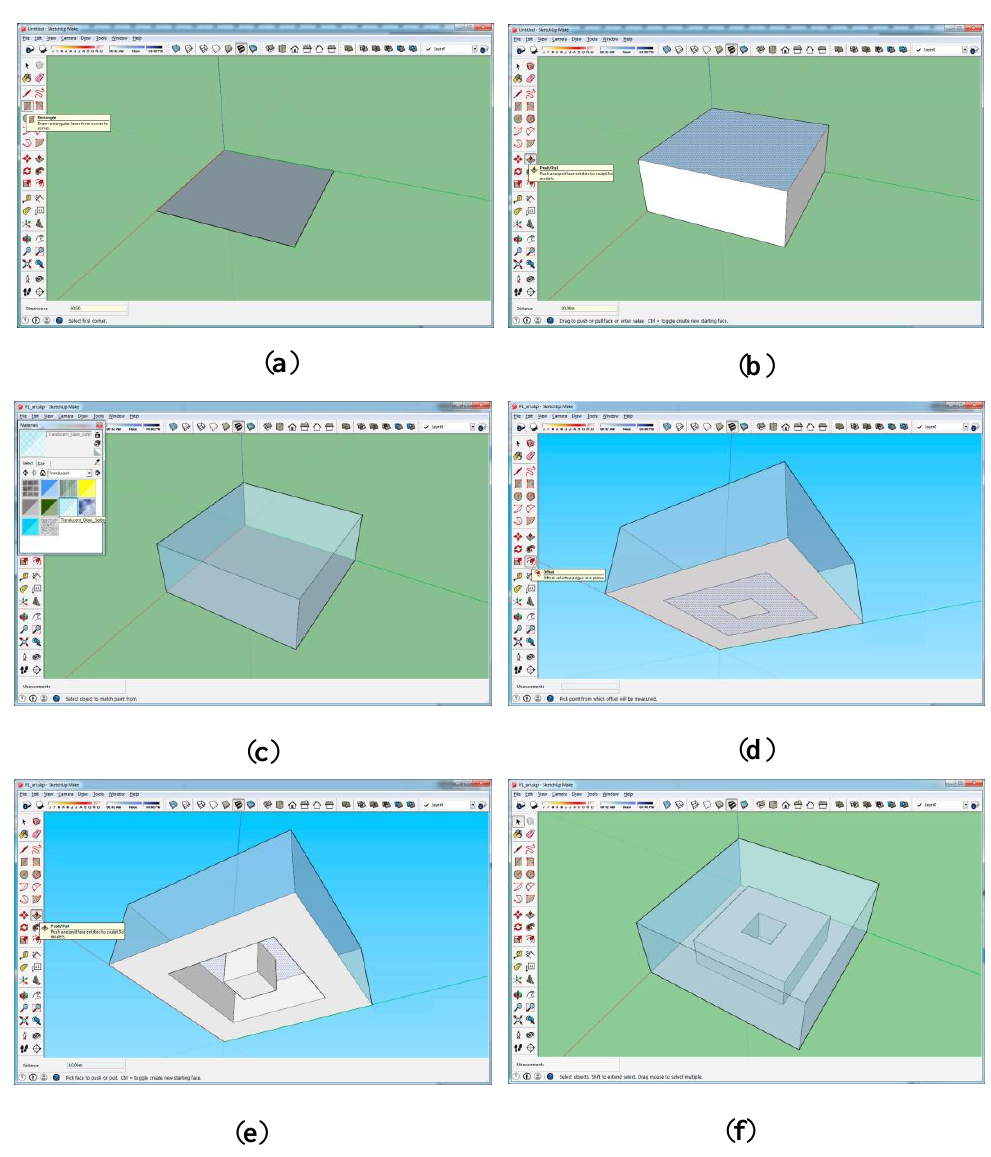
Figure 6. Case study geometry construction process in SketchUp, a to f process steps. ( a ): initial base dimension, ( b ): general volume, ( c ): internal volume, ( d ): 2D inner courtyard and surrounding exterior, ( e ): same in 3D, ( f ): final shape with all its dimensional properties.